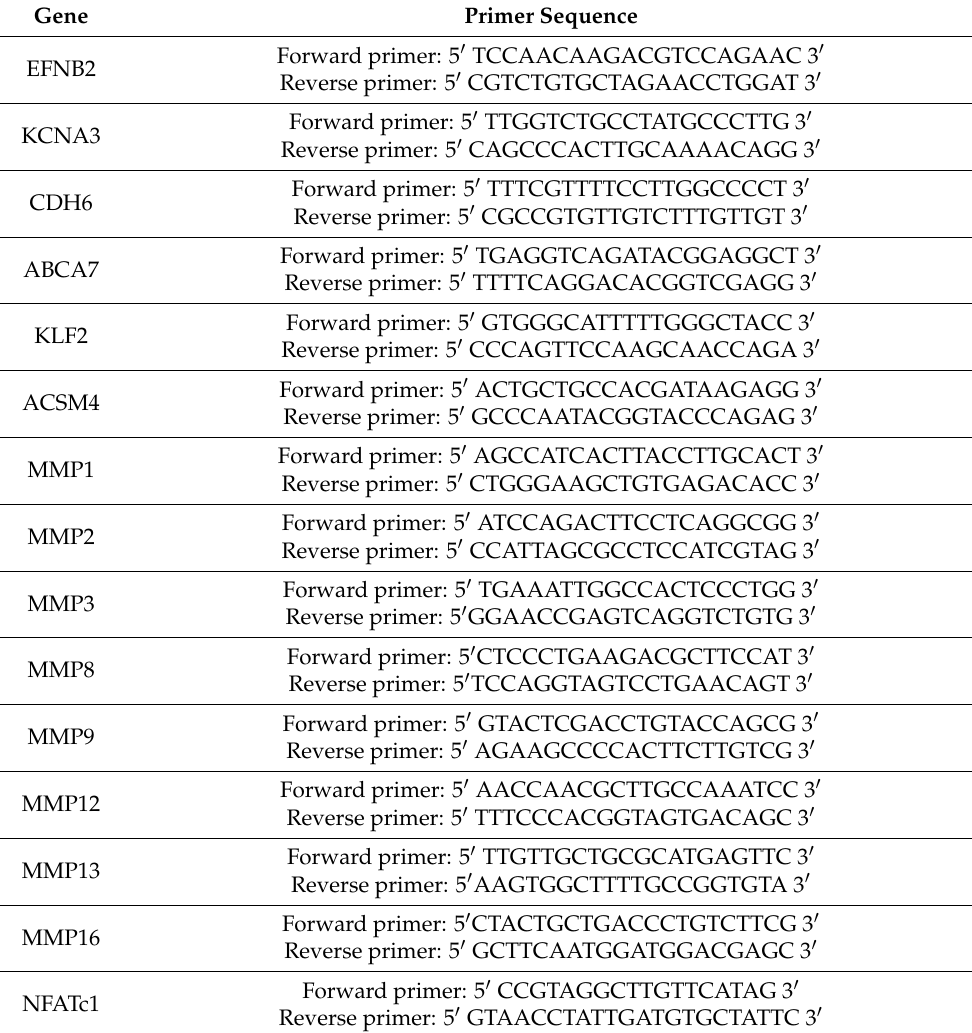
Table 2. List of primers and their